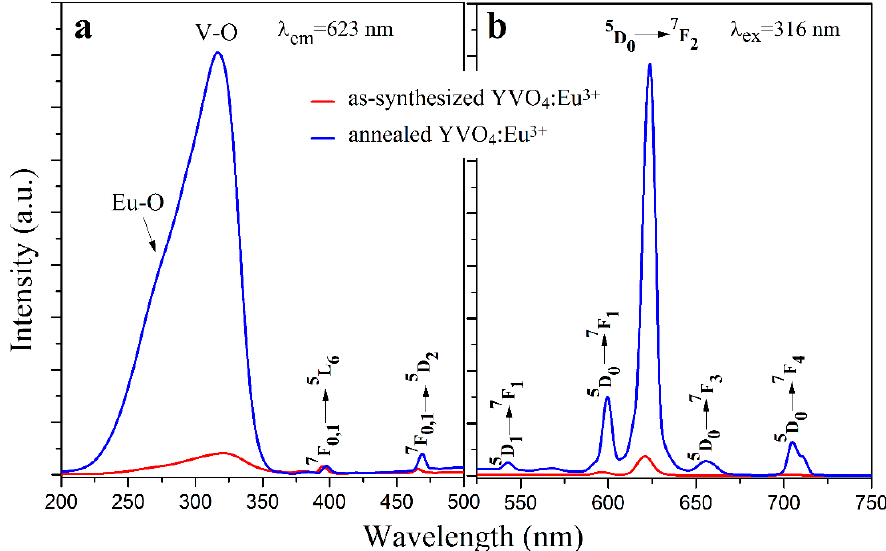
Figure 6. The excitation ( a ) and emission ( b ) spectra of the as-synthesized (unannealed) and the annealed YVO 4 :Eu 3+ nanoparticles.